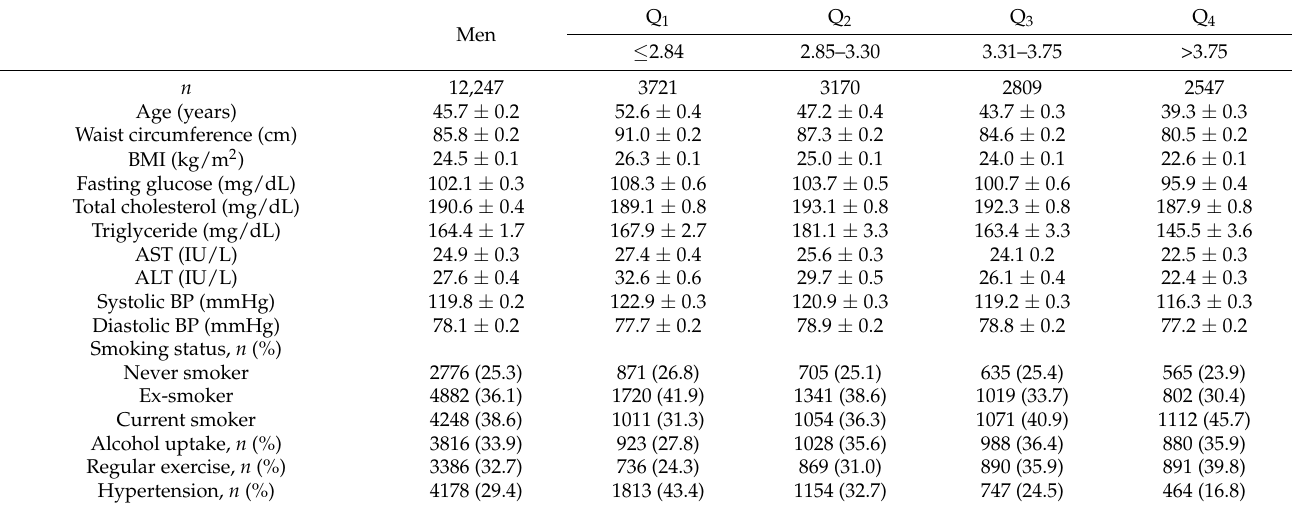
Table 1. Baseline characteristics of the study population according to the RGS